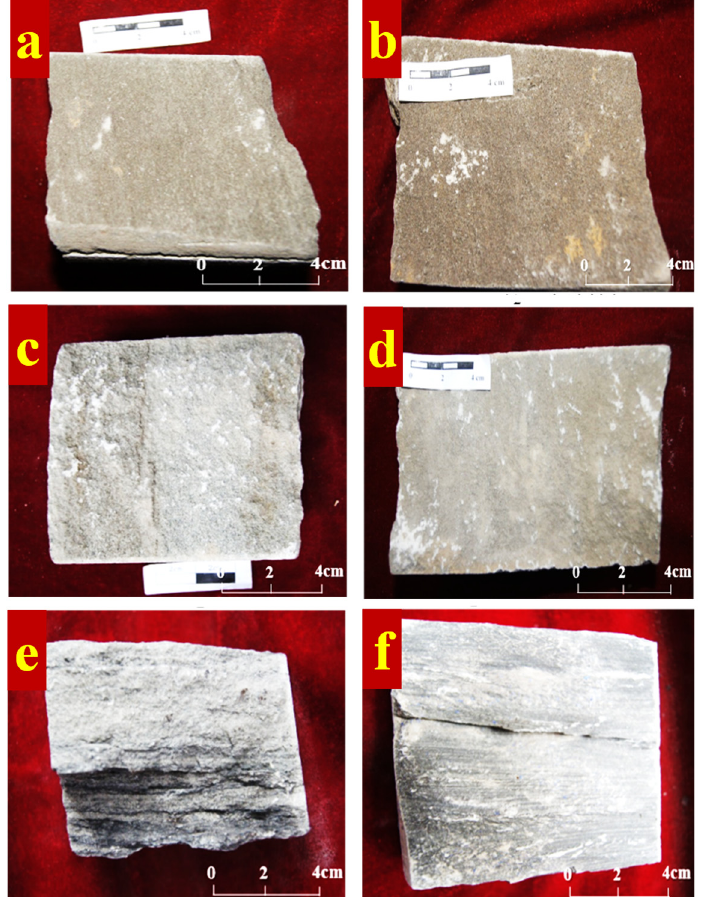
Figure 1. Pictures of the evaluated core samples. ( a , b ) show sandstone samples with high oil satu- ration. ( c , d ) indicate sandstone samples with medium oil saturation. ( e , f ) display sandstone samples saturation. ( c , d ) Indicate sandstone samples with medium oil saturation. ( e , f ) Display sandstone with low oil saturation. samples with low oil